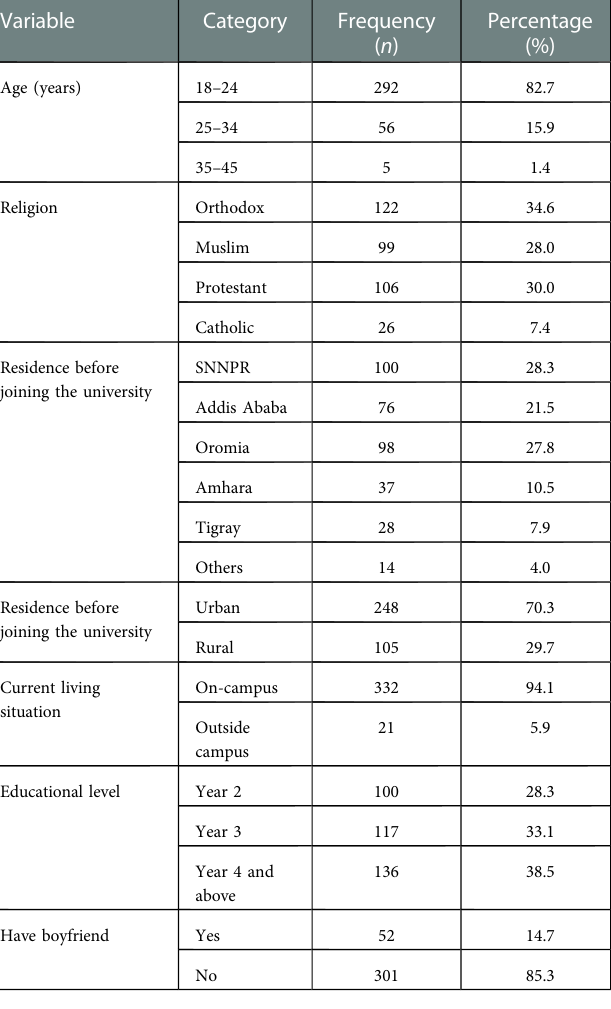
TABLE 3 Behavioral attributes among female university students, southwest Ethiopia, 2021 ( n =353).